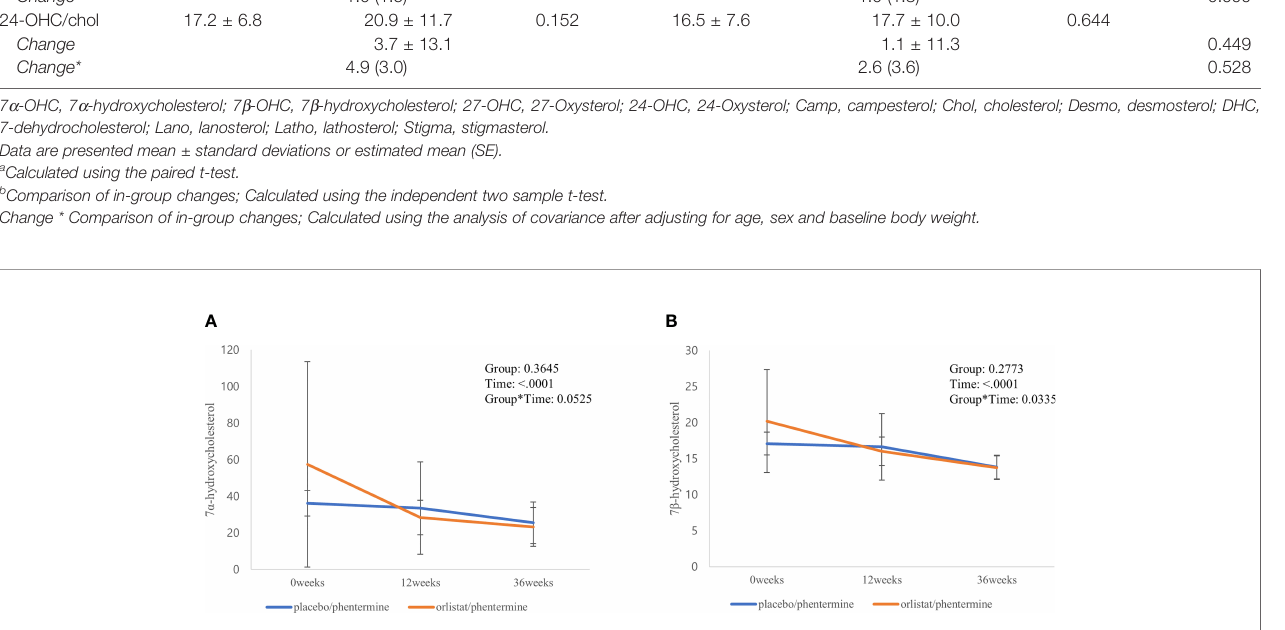
FIGURE 2 | Signi fi cant changes in individual sterols and their metabolic ratios from baseline through the follow-up period. (A) 7 a -hydroxycholesterol. (B) 7 b - hydroxycholesterol.